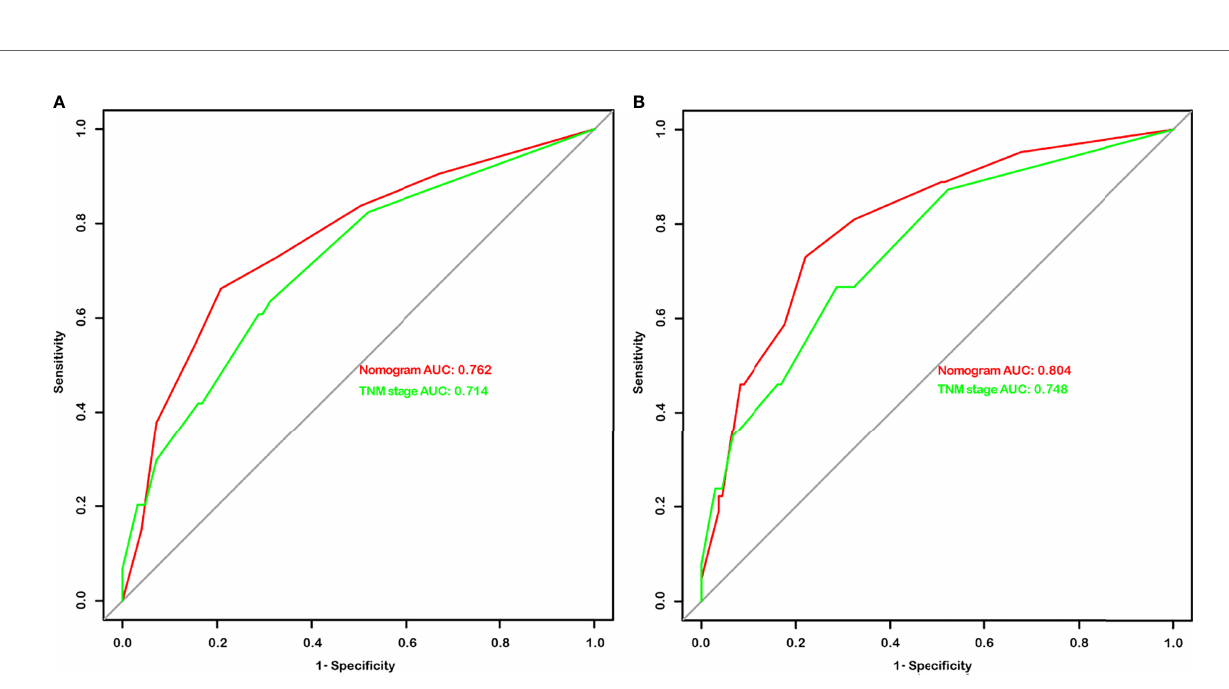
FIGURE 4 | The area under the curves (AUCs) of nomograms and the TNM stage in overall survival (OS) (A) and disease-free survival (DFS) (B) prediction after radical cystectomy were compared based on the results of receiver operating characteristic (ROC)